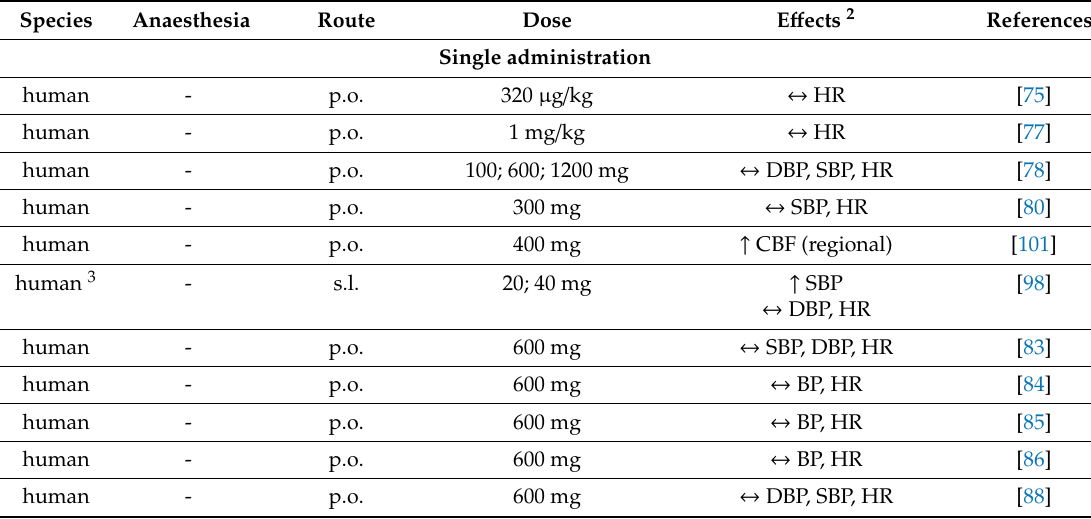
Table 2. In vivo e ff ects of cannabidiol (CBD) in cardiovascular system under physiological 1 conditions.